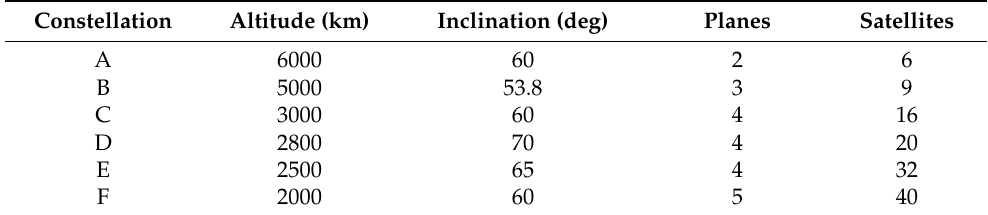
Table 3. Satellite constellations used in the simulation.